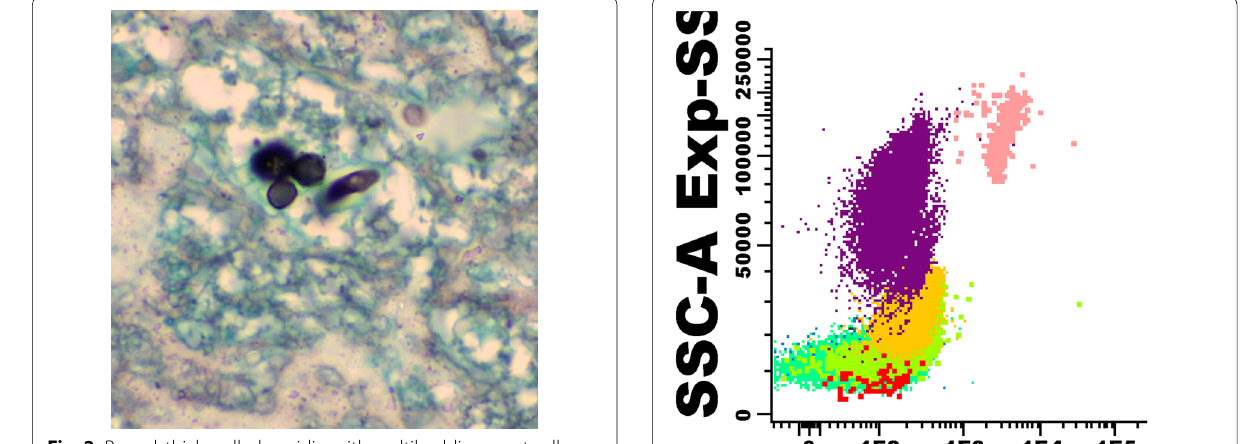
Fig. 2 Round, thick-walled conidia, with multibudding yeast cells (“Mickey Mouse ears”), compatible with Paracoccidioides brasiliensis. Grocott’s silver methenamine stain, 40 . Source: Authors × Fig. 4 Bone marrow flow cytometry reveals neutrophils (purple) and monocytes (yellow) lacking expression of cytoplasmic Myeloperoxidase. Eosinophils are depicted in pink, mature T lymphocytes in green (seafome green like), dendritic cells in green (lime green like) and residual T lymphoblast in red. Abbreviations: cyMPO, cytoplasmic Myeloperoxidase; FITC, fluorescein isothiocyanate; SSC-A, side scatter. Source: